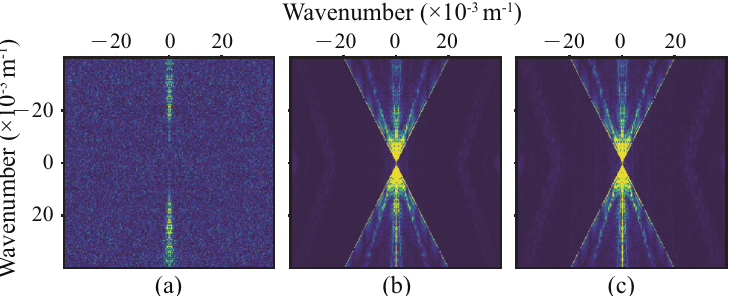
Figure 9. Wavenumber spectrum, ( a ) spectrum of Figure 8a, ( b ) spectrum of Figure 8c, ( c ) spectrum of Figure 8d.